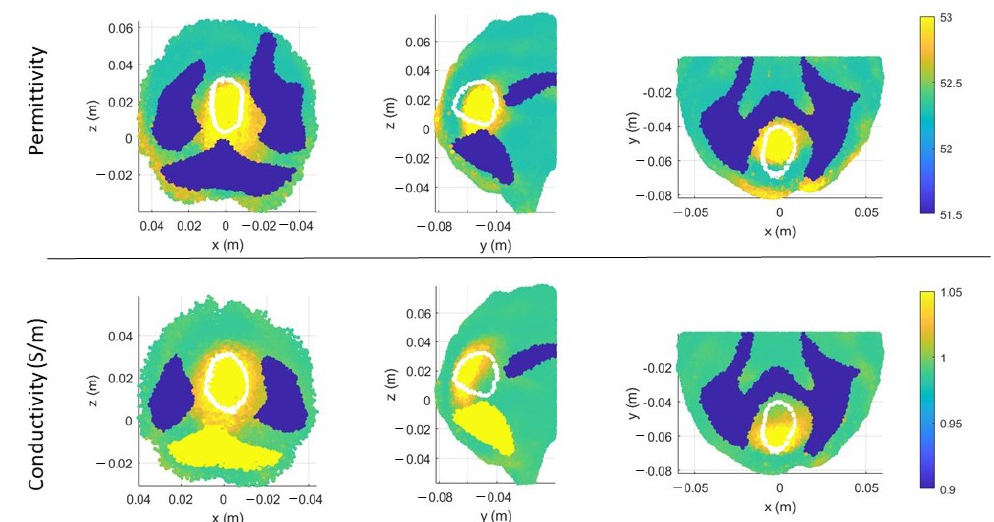
Figure 11. CSI algorithm results with the proposed discretization, considering half-brain DoI. Shape, position, and dielectric properties values of the stroke identified by the CSI algorithm after 100 iterations. On the first row, three different views of the permittivity, and on the second row, three different views of the conductivity. The perimeter of the expected stroke shape is shown in white.